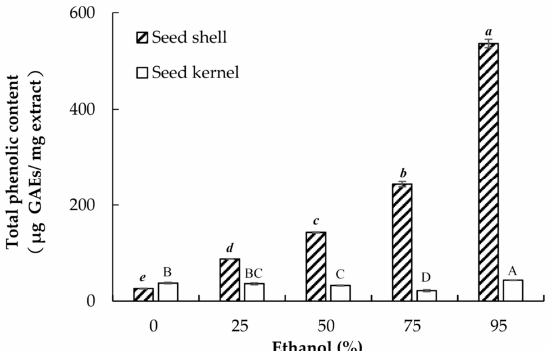
Figure 5. Total phenolic contents of the seed shell and kernel extracts obtained using ethanol solutions of different concentrations. Mean within the seed shell (in small letter) and within the seed kernel (in capital letter) followed by the same letter(s) are not significantly different at 5% level by Tukey test.